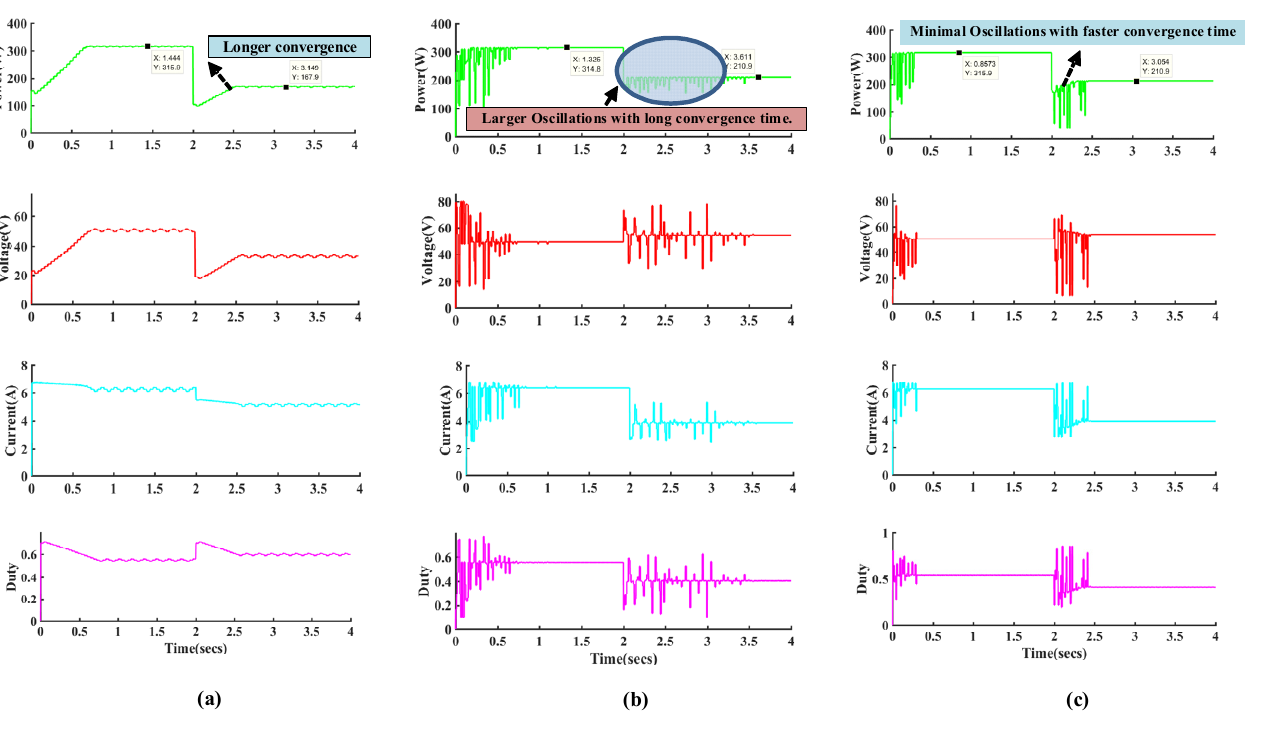
Figure 16. Simulated waveforms of ( a ) P& O, ( b ) PSO, and ( c ) SHO methods for pattern change in 4S2P configuration from Pattern 2 to Pattern 4.